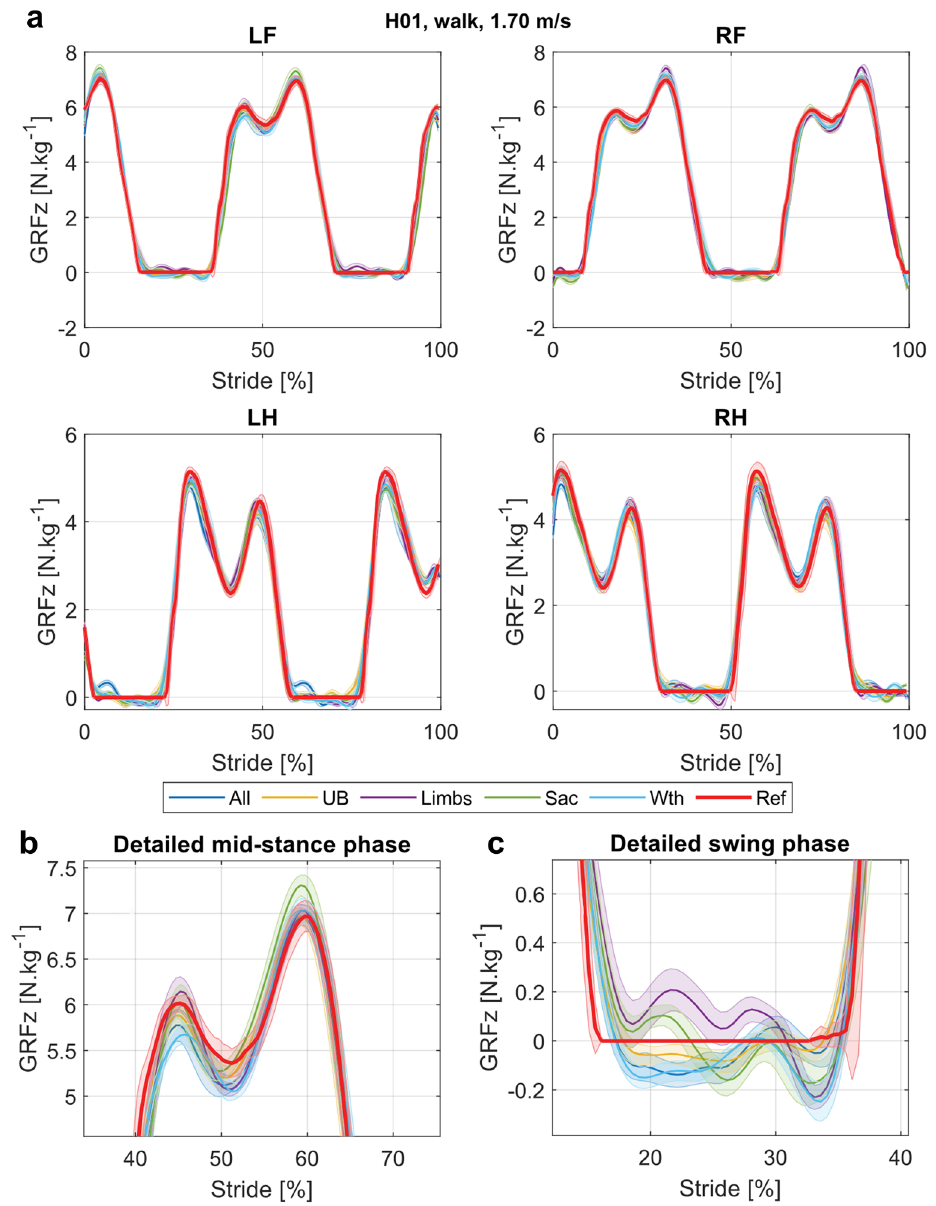
Figure 1. Example of GRFz curves predicted by the different nodes sets for the walk data, at 1.70 m/s. ( a ) GRFz for all limbs. The average strides are displayed as a bold line and standard deviations are shown by thin lines and shaded areas. The reference curves are shown in red (Ref: TiF reference), the curves predicted by models trained with all nodes (All: head, withers, sacrum and limb nodes) in orange, with upper-body nodes (UB: head, withers and sacrum nodes) in yellow, with limb nodes (Limbs: limb nodes) in purple, with the sacrum node (Sac: sacrum node) in green and with the withers node (Wth: withers node) in light blue. LF left front, RF right front, LH left hind, RH right hind. ( b ) Detailed comparison of the predictions during the stance phase of the LF limb. ( c ) Detailed comparison of the predictions during the swing phase of the LF